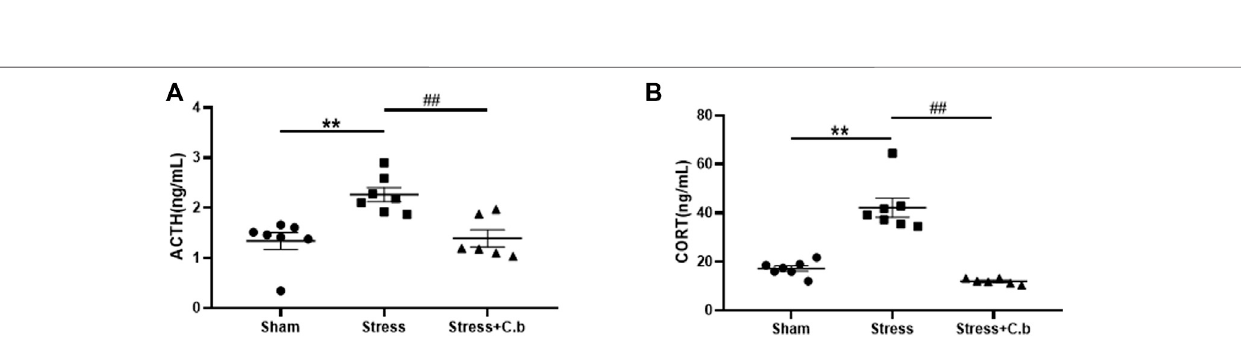
Frontiers in Pharmacology |